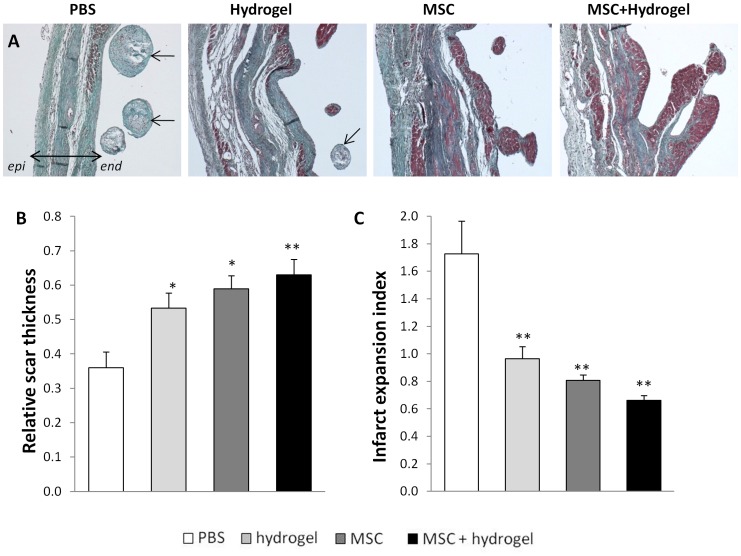
Evaluation of scar thickness and infarct expansion.(A) Representative photomicrographs of Masson trichrome staining of the scar area (collagen-rich areas in blue and healthy myocardium in red). The double arrow depicts the LV wall (epi, epicardium; endo, endocardium). The arrows show chondroid metaplasia of the endocardium. Scale bar = 0.5 mm. (B) Relative scar thickness (scar thickness/wall thickness). (C) Infarct expansion index ([LV cavity area/whole LV area]/relative scar thickness). For (B) and (C): *p<0.05 and **p<0.001, one-way ANOVA. All values represent mean ± SEM.